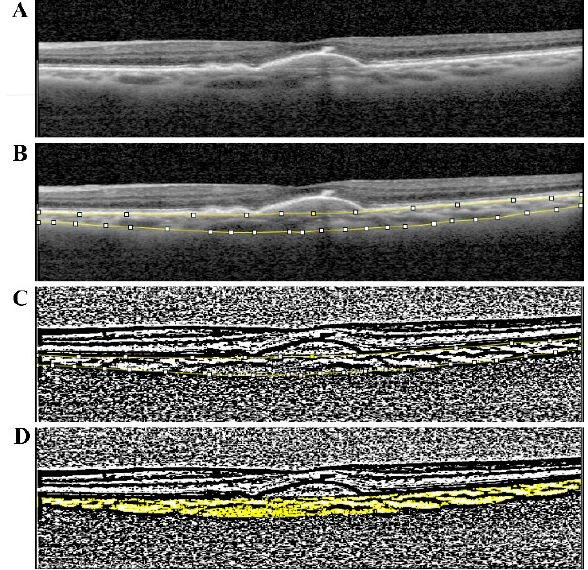
Figure 1. Examples of image binarization of the Choroid. ( A ) Macular SD-OCT-EDI centered on fovea and 6000 µm centered section in the fovea. ( B ) Manual measurement of the choroidal thickness. Yellow lines delimit inner boarder—Bruch’s membrane and outer boarder—escleral transition. ( C ) Image binarization—converting grey scale in binarized images. ( D ) Studied area and image software: Black pixels images (vascular lumen) and white pixels images